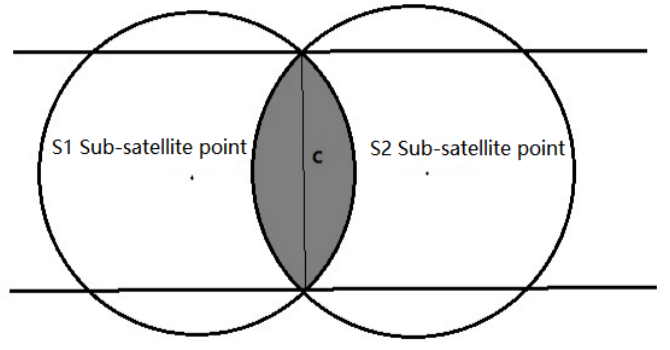
Figure 2. Street of coverage formed by two satellites. The width C 1 of the coverage band formed by S satellites can be expressed as: